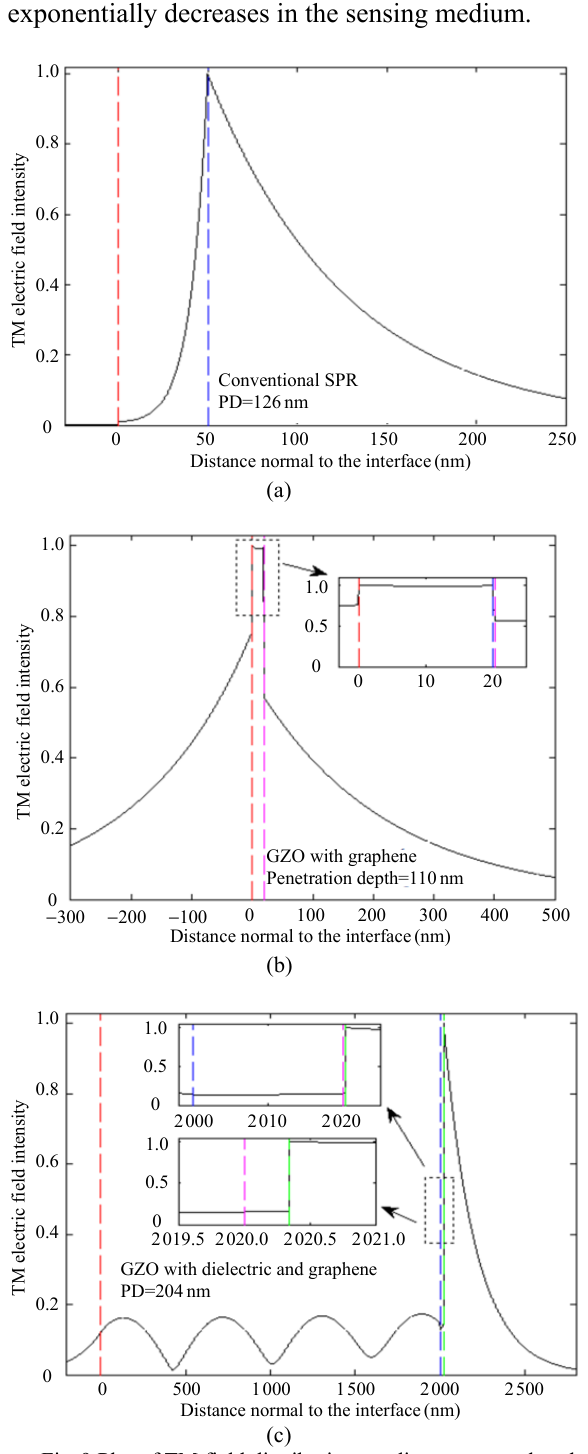
Fig. 9 Plot of TM field distribution vs. distance normal to the interface (nm) for (a) conventional SPR sensor, (b) GZO/ graphene SPR sensor, and (c) dielectric/GZO/graphene SPR sensor.